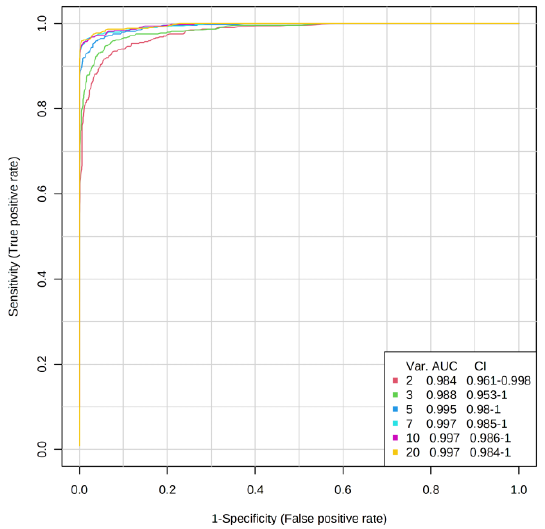
Figure 2. ROC curve with AUC values for systems of COVID-19 patients on Day 1 vs. controls, determined by random forest algorithm with relative concentrations of metabolites in blood plasma as input variables; analysis run in metaboanalyst [16].